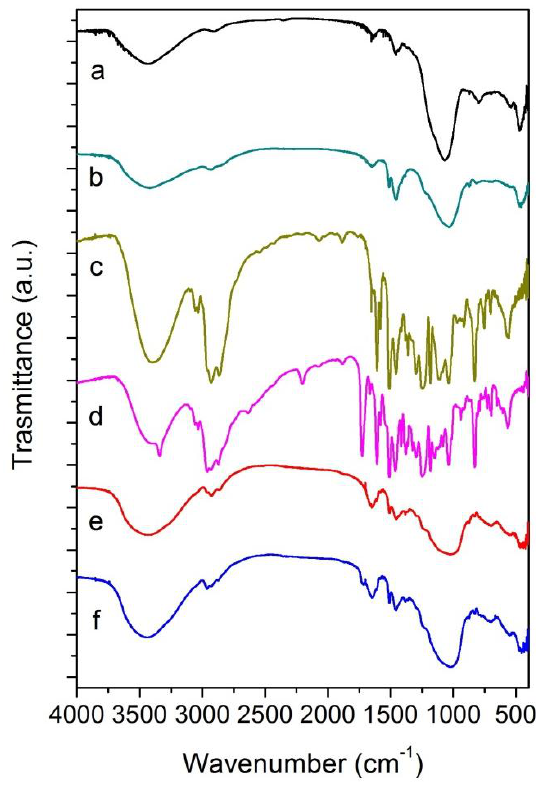
Figure 4. FT-IR spectra of (a) metakaolin; (b) geopolymer; (c) Epojet ® ; (d) EpojetLV ® ; (e) Geo-Epojet20; and (f)